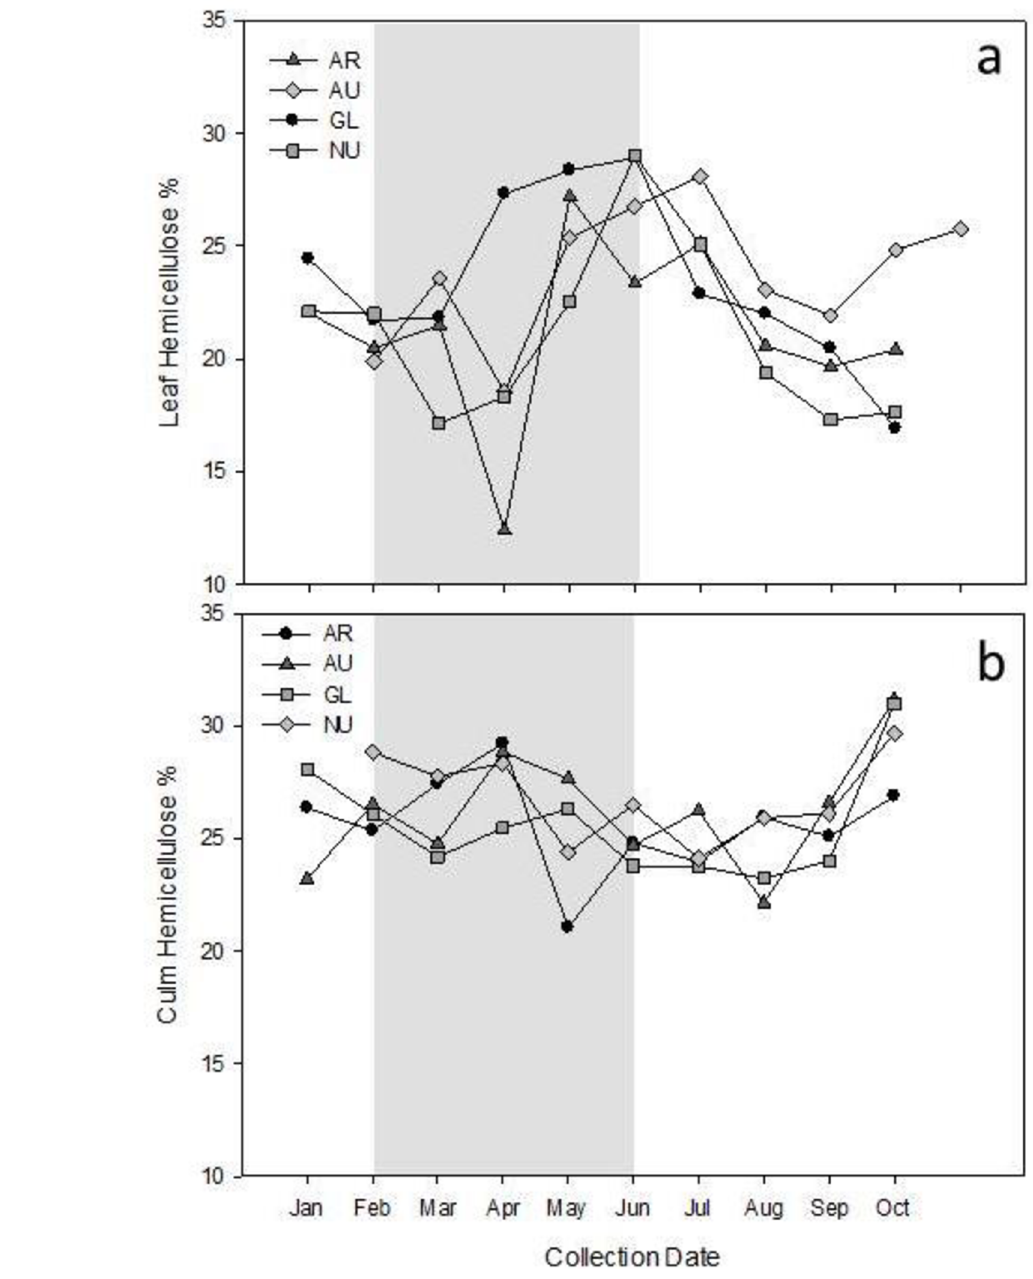
Fig 3. Hemicellulose content of bamboo leavesand culm. Percentageof hemicelluloses in leaf (panela) and culm (panelb) of bamboo species Phyllostachys ( P .) aurea (AR), P . aureosulcata (AU), P . glauca (GL), and P . nuda (NU) expressedon a dry matter (DM) basis. The shaded area representsthe time when captive giant pandasconsumed primarily culm.